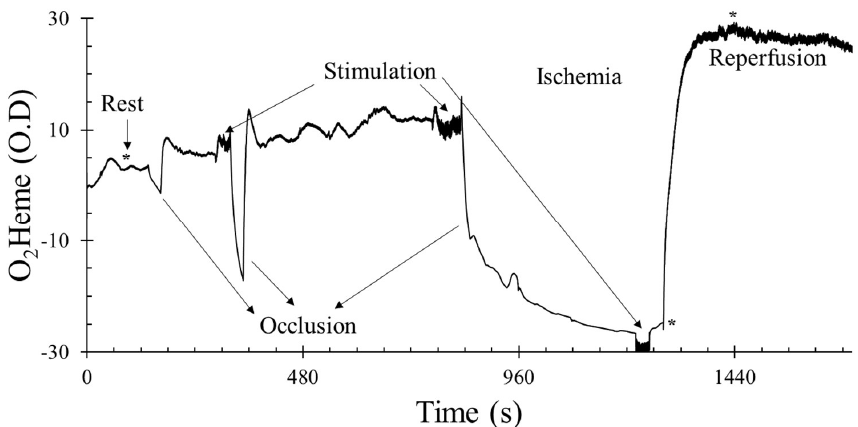
Figure 1. An example of the testing protocol using the oxygenated hemoglobin / myoglobin (O 2 heme) signal. The y -axis scale is in optical density units. * shows the approximate time points when pulse size was calculated at rest, immediately after ischemia, and during reactive hyperemia. O 2 heme and deoxygenated hemoglobin / myoglobin (Heme) physiological calibration reached 0% during ischemia and 100% at peak hyperemia.